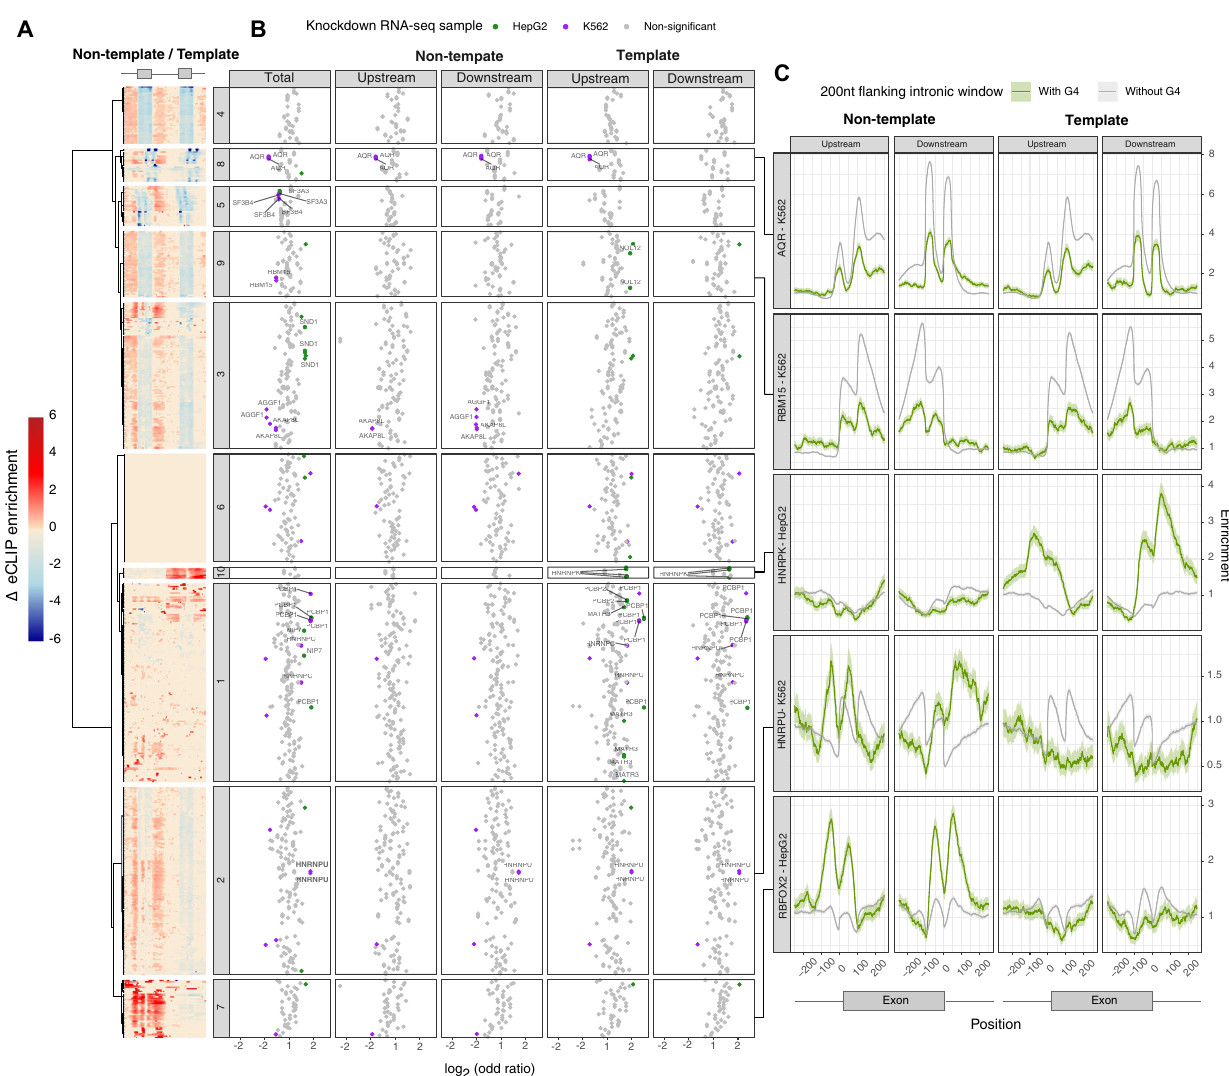
Fig. 6 The interplay between RNA binding proteins and G4 motifs in proximity to splice sites. A Enrichment difference in the distribution of RBPs in sites with and without G4 motifs is shown for the template and non-template G4 orientations. Heatmap displaying the clustering of differential enrichment values of each RBP between splice sites fl anked by non-template (left) or template (right) G4s. B Functional assessment of the RBP effect on alternative inclusion of exons fl anked by G4 motifs. Each dot represents a single replicate performed for an RBP on a given cell line. Log(odds ratio) of differential inclusion for sites with and without G4 motifs, following RBP KO experiments. Signi fi cant associations between RBPs and alternative inclusion of G4- fl anked exons are highlighted either in green (HepG2) or purple (K562). Labelled factors are the set of high-con fi dence factors identi fi ed by consistent eCLIP and LoF followed by RNA-seq analyses. Results are shown in aggregate, as well as for template and non-template orientations separately. Statistical evaluation was performed using chi-squared tests with Bonferroni corrections. Results for both eCLIP and RNA-seq experiments that target the same factor are shown side by side. C Enrichment of a panel of RBP binding sites across splice sites fl anked or not fl anked by G4 motifs. Displayed factors are AQR, RBM15, HNRPK, HNRPU and RBFOX2, each of which belongs to a different eCLIP cluster. The error bands represent 95% con fi dence intervals based on a binomial